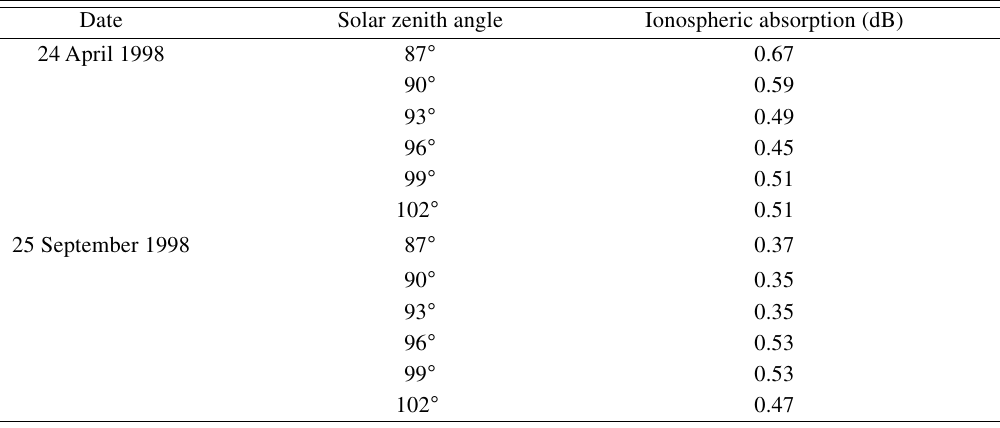
Table II. Hourly ionospheric absorption data as function of the solar zenith angles between 87 ° and 102 ° ; the days where the magnetic storm affects the ionospheric absorption more than the solar proton flux were